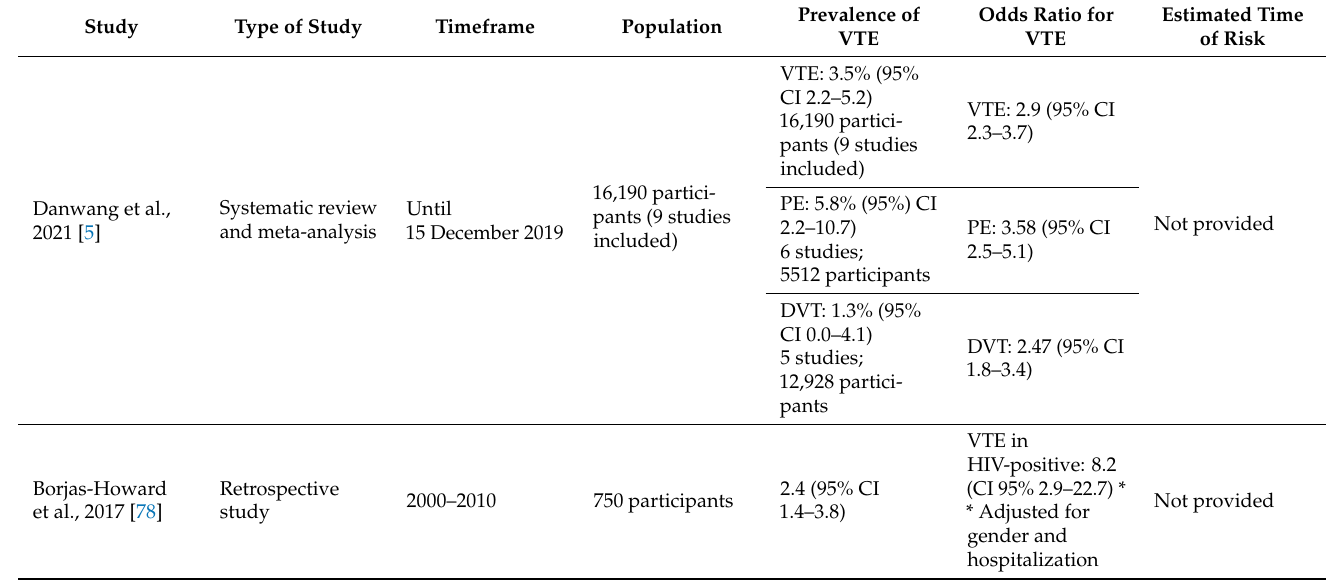
Table 4. Characteristics of studies included in this review regarding the relationship between tuberculosis and venous thromboembolic disease